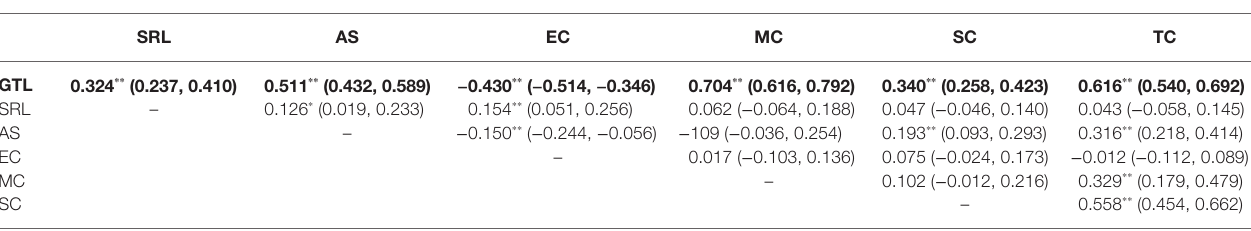
TABLE 1 | Multivariate correlations and 95%